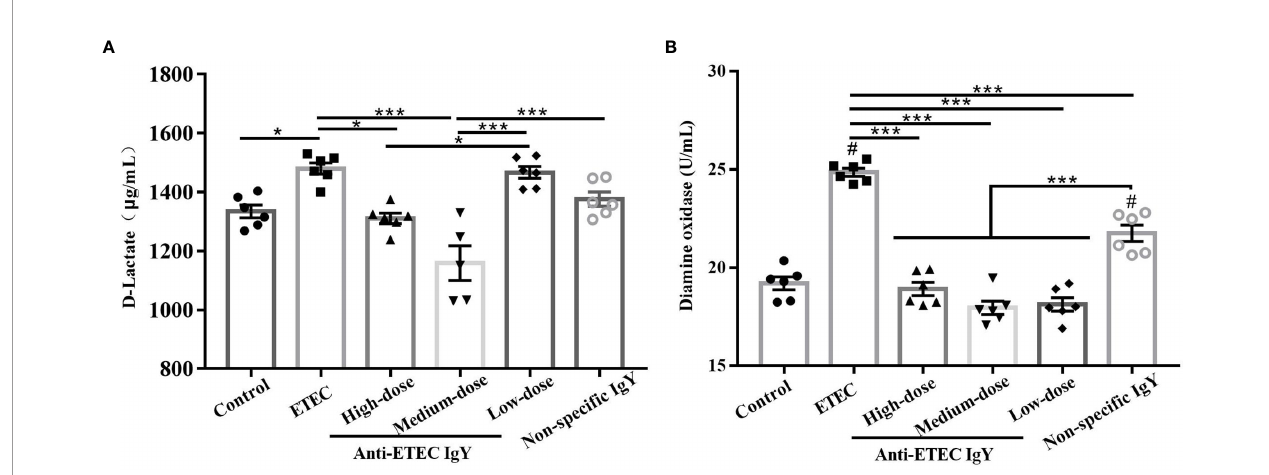
FIGURE 7 | D-Lactate (A) and diamine oxidase (B) contents in serum of control (neither IgY nor ETEC infection) mice, ETEC-infected mice, ETEC-infected mice treated with high-, medium- or low-doses anti-ETEC IgY or ETEC-infected mice treated with non-speci fi c IgY. Values are expressed as least squares mean ± SEM, n =6. * P < 0.05, *** P < 0.001. # P < 0.05 compared to control group.